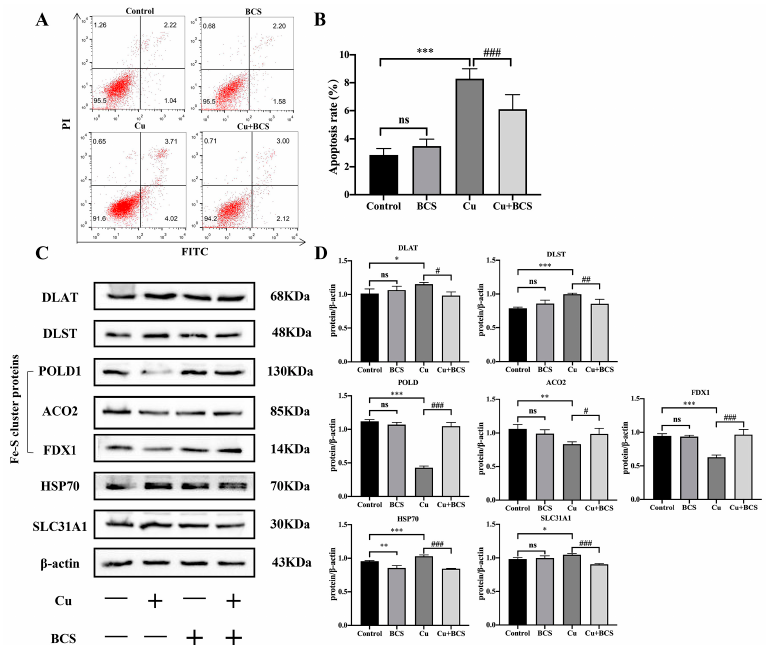
Figure 6. Effects of Cu on the expression of cuproptosis-related protein. ( A ) Proteins expression of DLAT, DLST, POLD1, ACO2, FDX1, HSP70 and SLC31A1 in mouse hippocampus. ( B ) Quantitative analysis of DLAT, DLST, POLD1, ACO2, FDX1, HSP70 and SLC31A1, * p < 0.05, ** p < 0.01, *** p < 0.001.